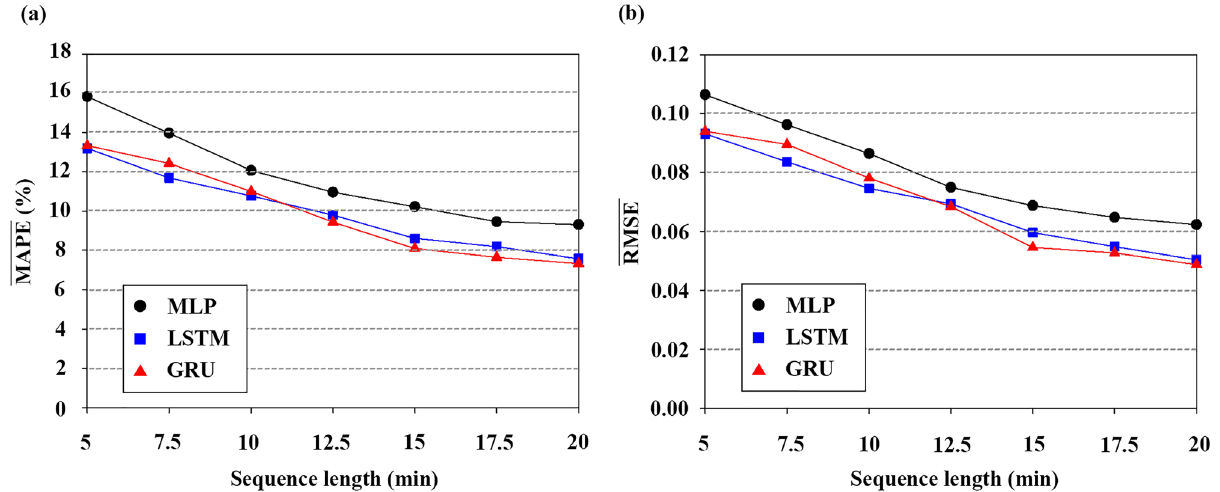
Figure 4. ( a ) MAPE (%) of the individual models according to sequence length (min). MAPE is the mean MAPE over 30 repeated experiments. ( b ) RMSE of the individual models according to sequence length (min). RMSE is the mean RMSE over 30 repeated experiments.